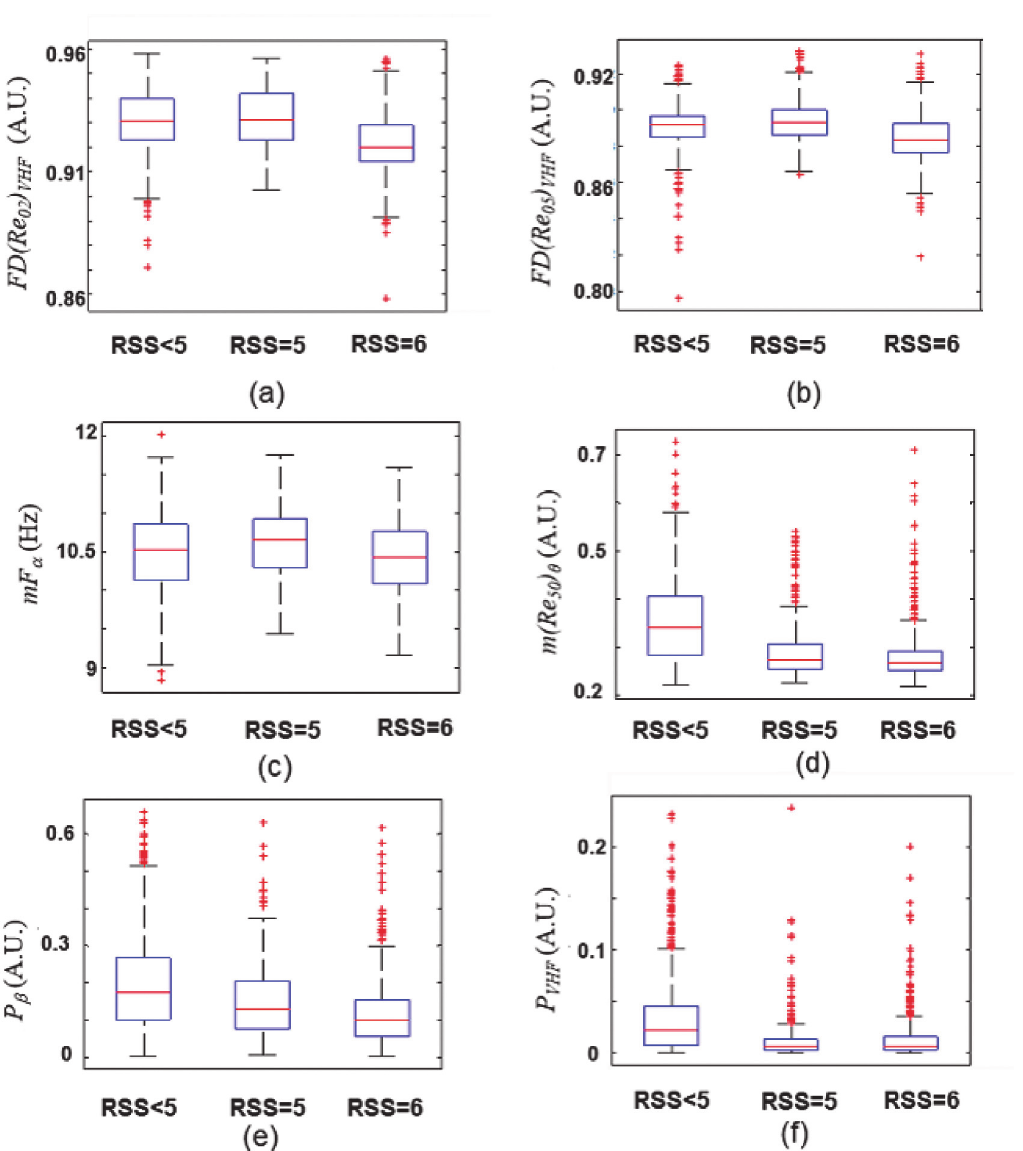
Fig 4. Values of EEG Measures with Ramsey score (RSS). Distribution of the values of (a) first decay of Auto-Mutual Information Function (AMIF) in VHF (105 – 145 Hz) band for q = 0.2, (b) first decay of AMIF in VHF (105 – 145 Hz) band for q = 0.5, (c) weighted mean frequency in α band, (d) mean value of AMIF in θ band for q = 50, (e) power spectral density in β band, (f) power spectral density in VHF (105 – 145 Hz) band. On each box, the central mark is the median; the edges of the box are the 25th and 75th percentiles. The whiskers are lines extending from each end of the boxes to show the extent of the rest of the data. Values beyond the end of the whiskers are considered outliers and marked with a